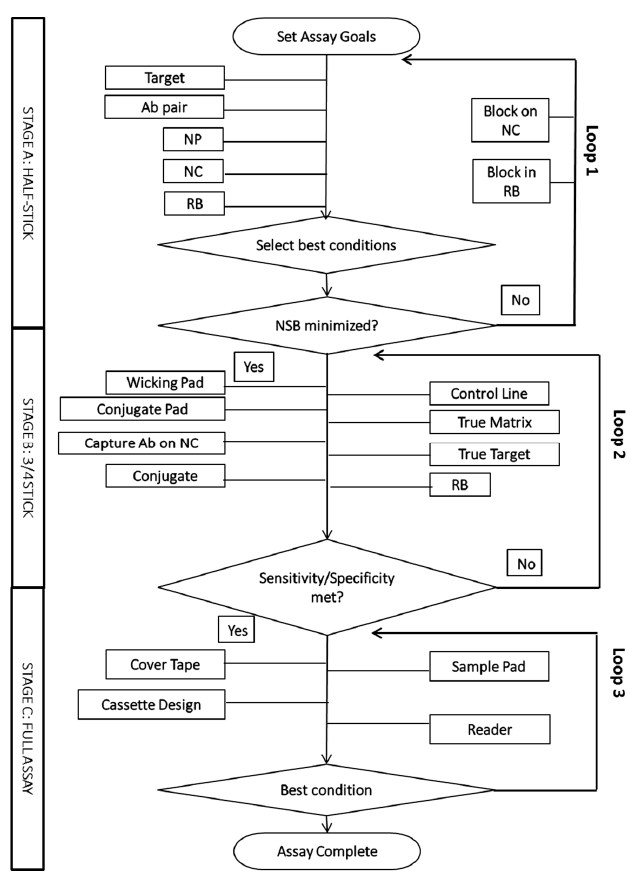
Figure 2. Flowchart indicating typical lateral flow assay (LFA) optimization. Ab, antibody; NP, nanoparticle; NC, nitrocellulose; RB, running buffer.